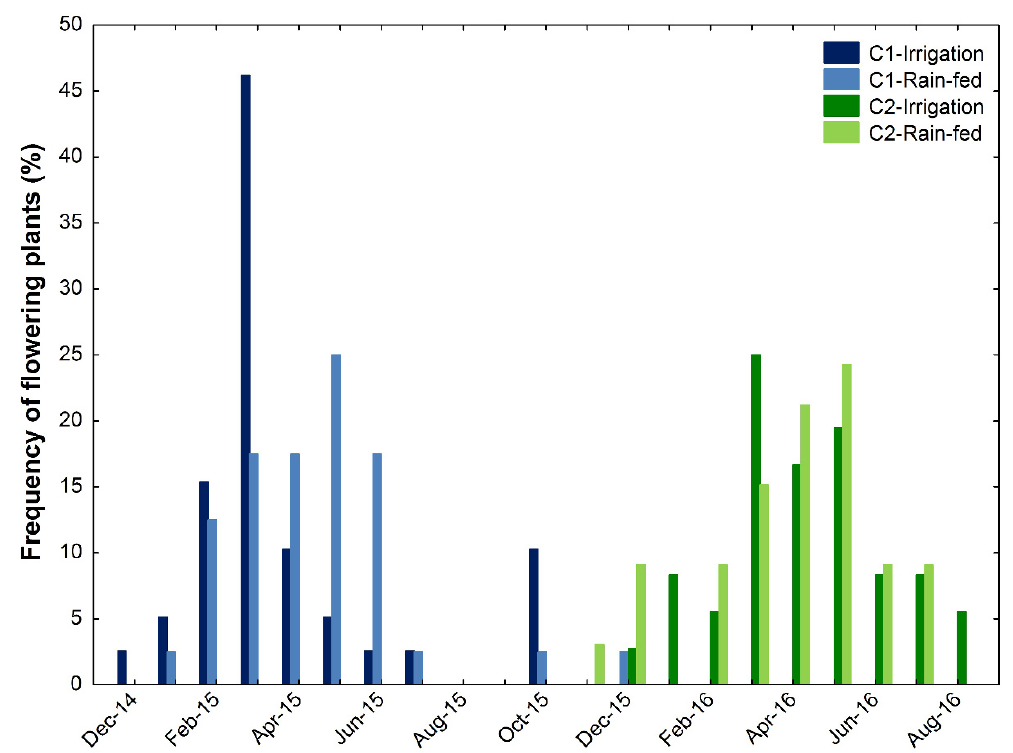
Figure 5. Effect of seasonal drought on flowering time. Percentage of plants that flowered each month per treatment (irrigated vs. rain-fed) and cycle covering the flowering period of all four Musa genotypes. C1: first crop cycle; C2: second crop cycle.